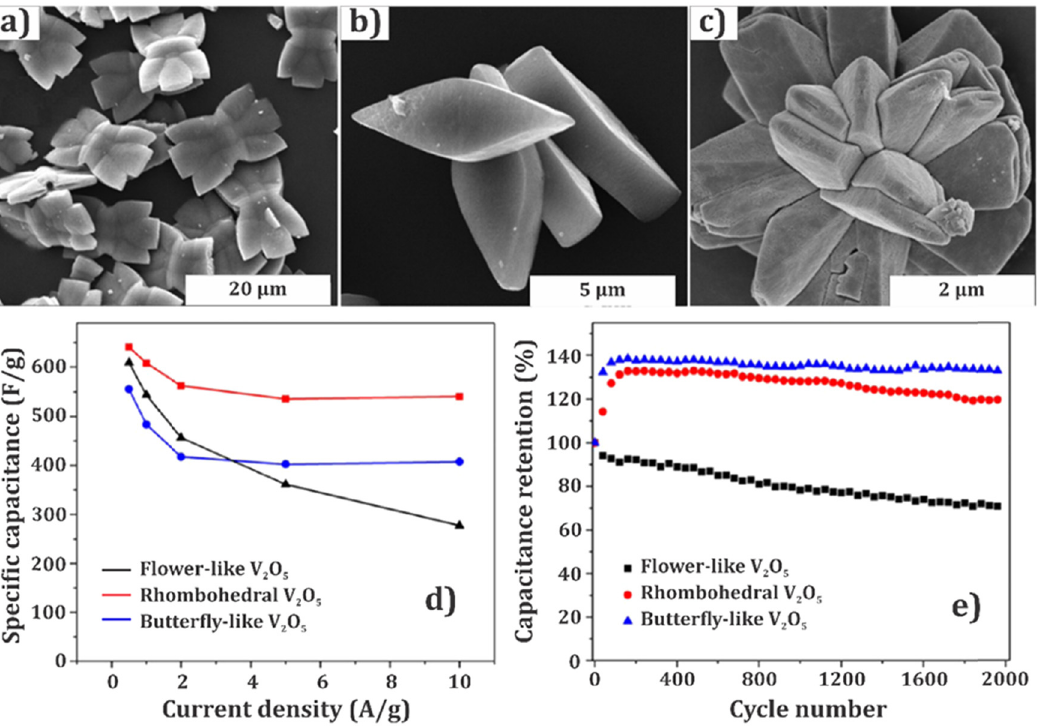
Figure 7: SEM images of ( a ) butter fl y - like, ( b ) rhombohedral, and ( e ) fl ower - like V 2 O 5 . Electrochemical performance of butter fl y - like, rhombohedral, and fl ower - like V 2 O 5 : ( d ) speci fi c capacitances of V 2 O 5 with di ff erent morphologies calculated from GCD curves at di ff erent current densities and ( e ) cycling performance of V 2 O 5 with di ff erent morphologies collected at 100 mV s − 1 [ 72 ]